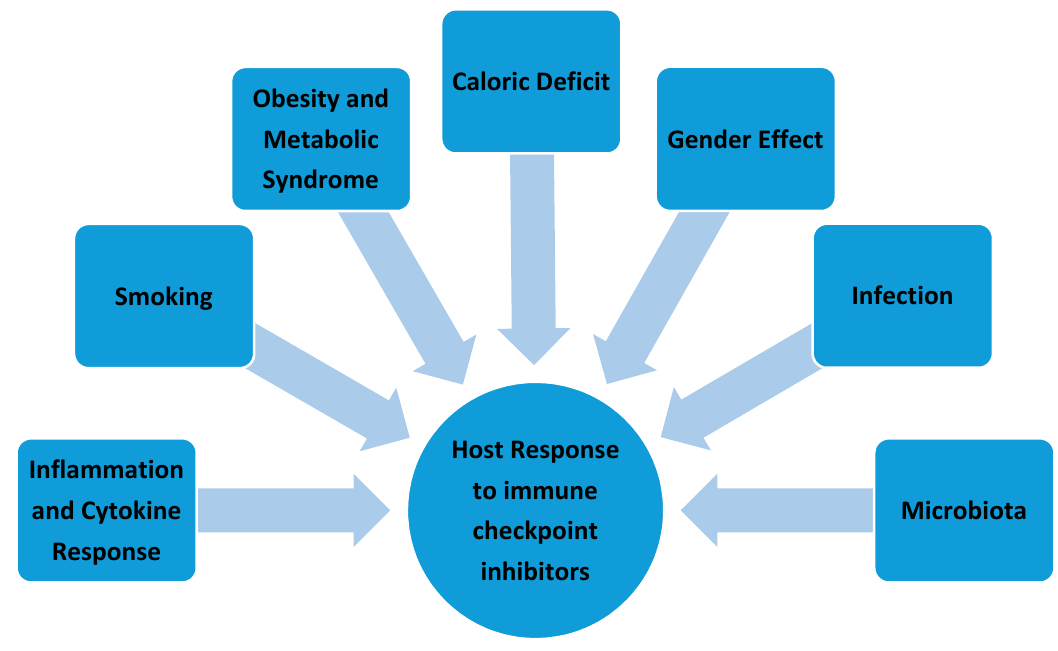
Figure 6. Environmental and host factors affecting the anti-tumor response of immune checkpoint inhibitors.